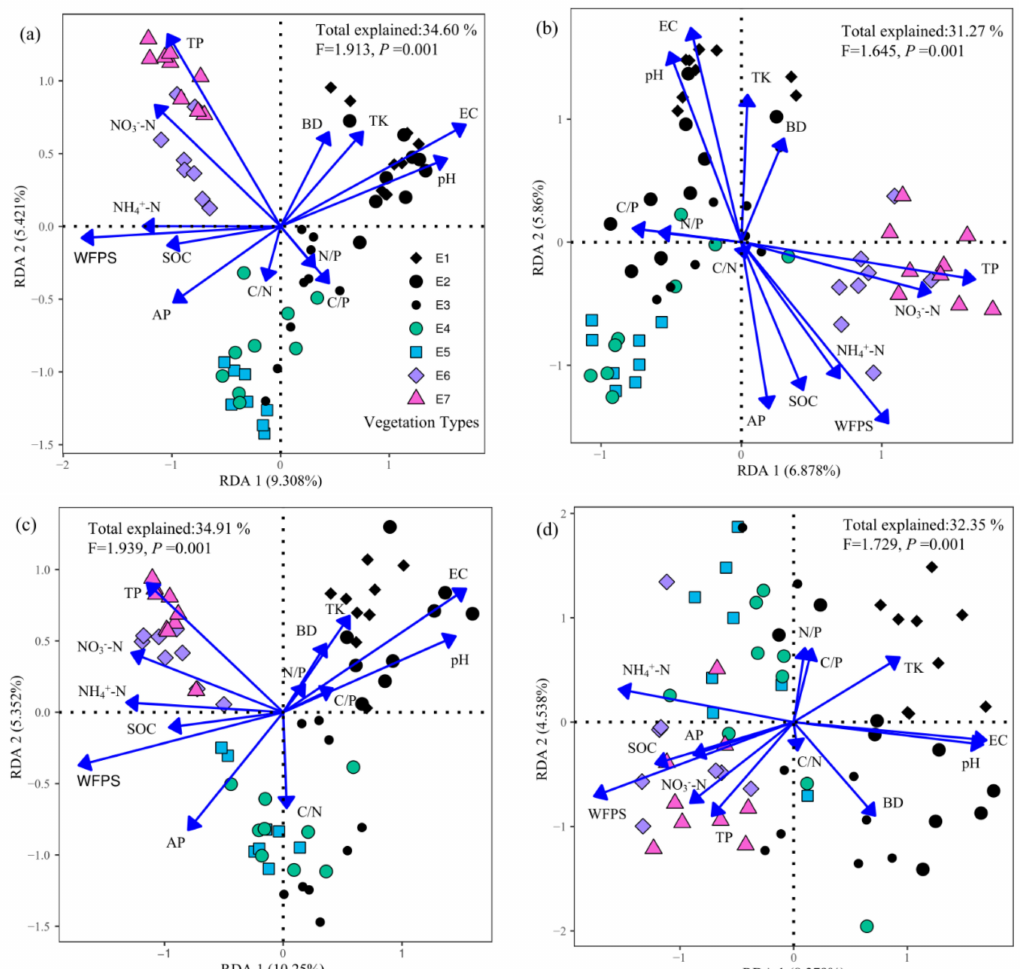
Figure 5. Distance-based redundancy analysis (db-RDA) demonstrated the effect of soil properties on community composition of soil total fungi ( a ), symbiotic fungi ( b ), saprophytic fungi ( c ), and pathogenic fungi ( d